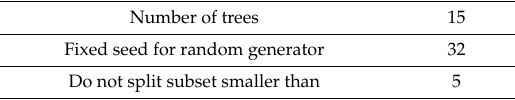
Table 1. Parameters of the Random Forest (RF).